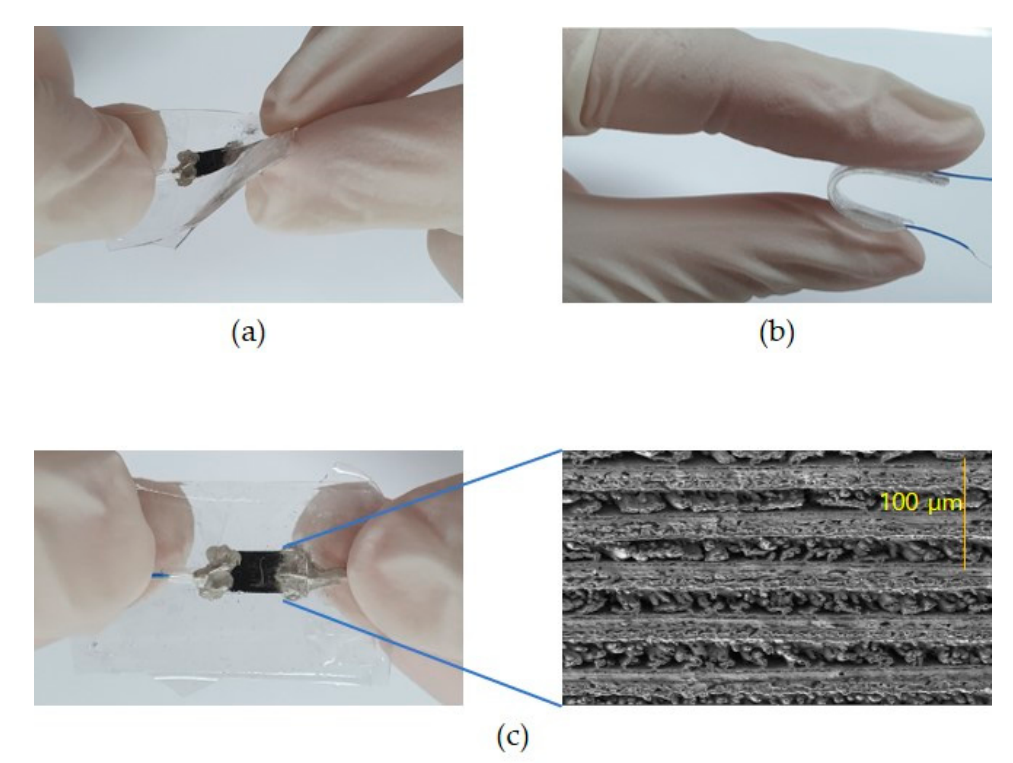
Figure 5. The graphene-like flake structure of the LIG pattern; ( a ) SEM image of the graphene-like flake structure of LIG; ( b ) Raman spectra of the LIG pattern irradiated laser with different laser fluences.